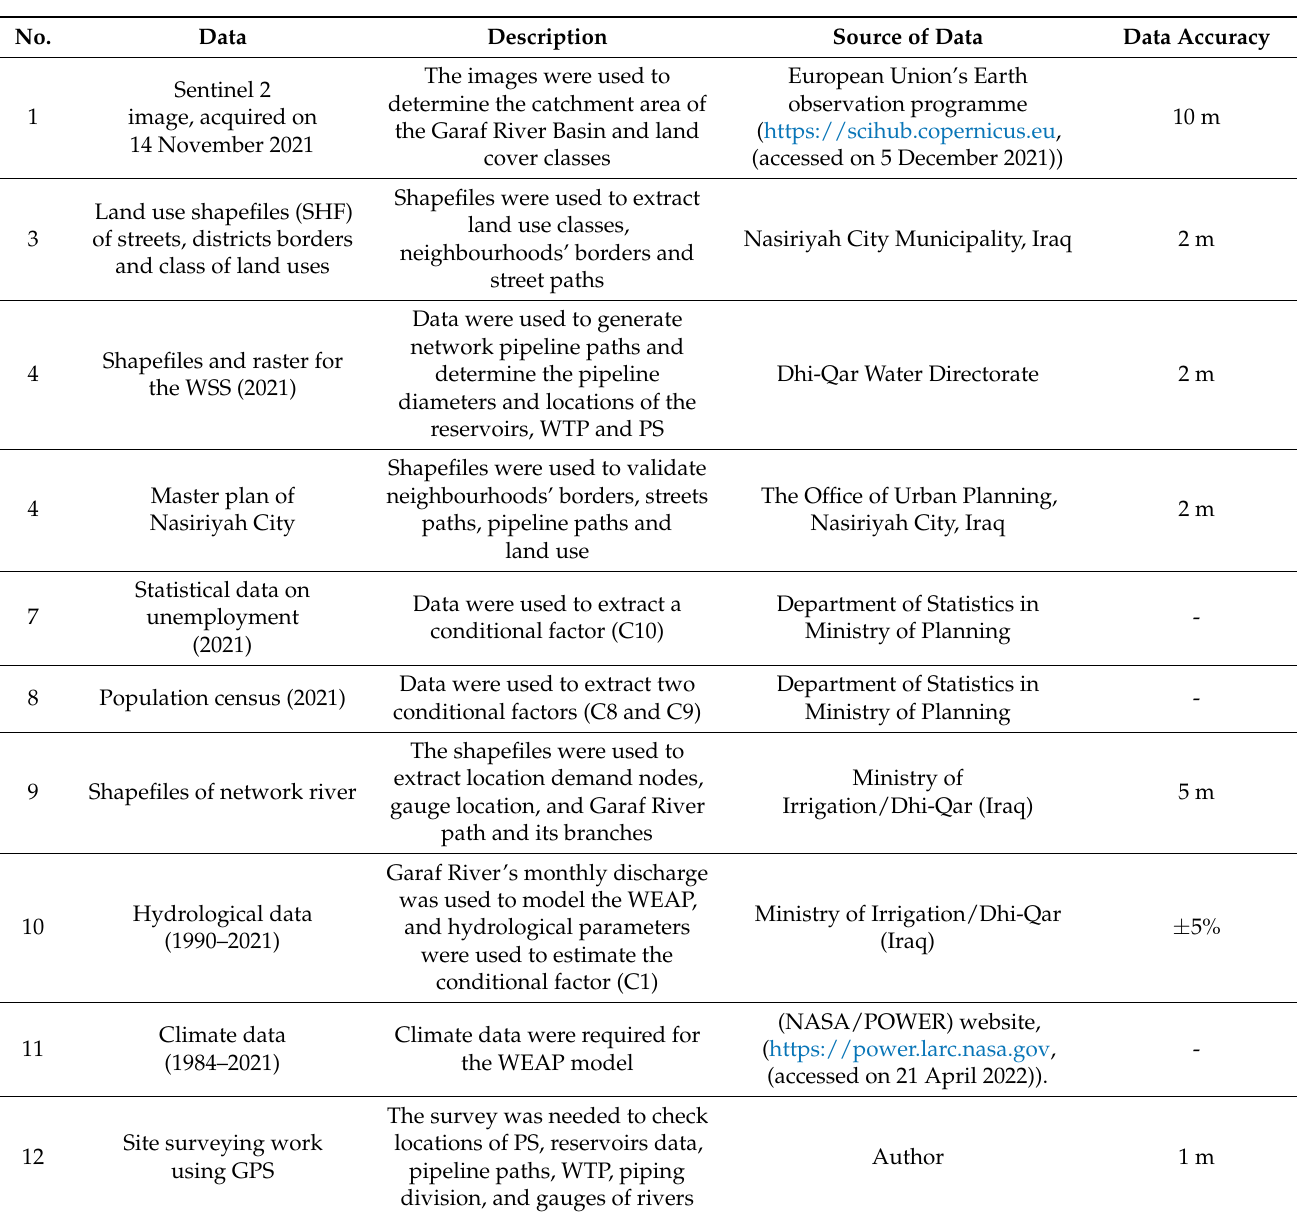
Table 1. Data collected from the Nasiriyah City and some reliable open data source websites for this